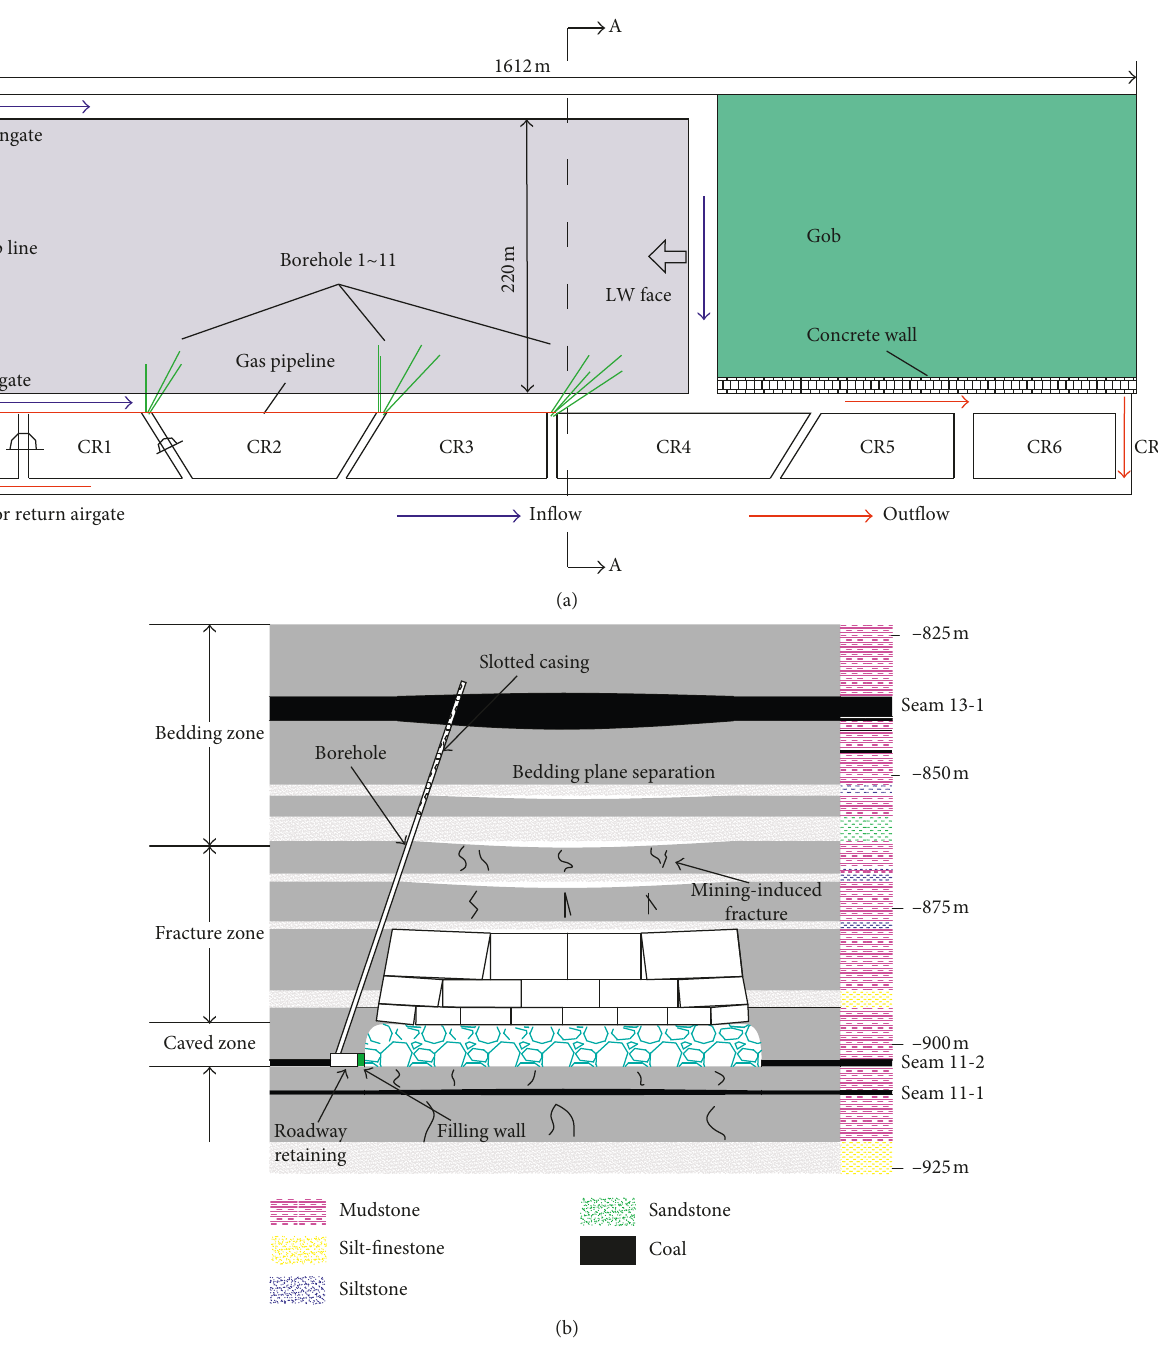
Figure 1: Panel 1111(1) and testing boreholes. (a) Plan view. (b) A-A section. The figure was reproduced from Xue et al. [21] (under the Creative Commons Attribution License/public